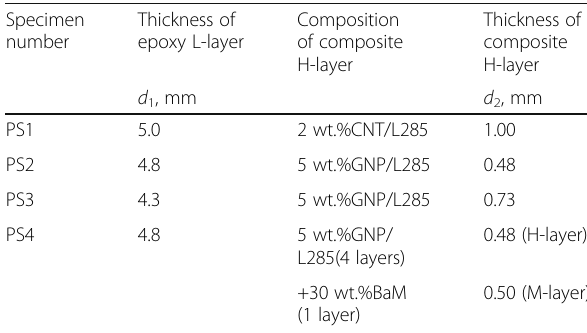
Table 1 Parameters of fabricated photonic structures based on epoxy L-layers and composite